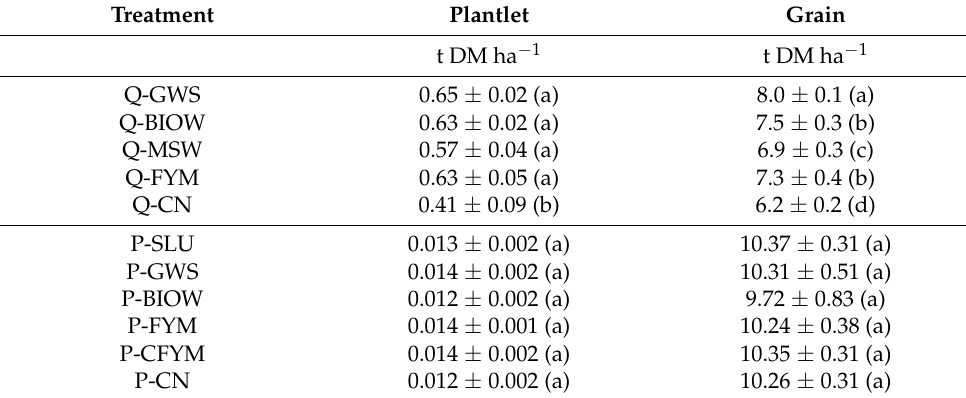
Table 6. Biomass of plantlets and grain yields (t DM ha − 1 , DM for dry matter), with the following data presented: mean values ± standard deviation of the four replicates (in each site, abc letters stand for significant difference between treatments with Newman–Keuls and Kruskal–Wallis